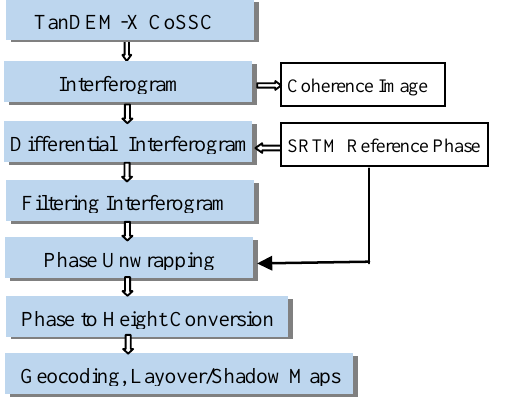
Figure 3. TanDEM-X inteferometric processing work flow. LiDAR and Digital Photogrammetric Stereo DEM are produced with 2 m resolution using the post processing software. For analysis, these DEMs have been resampled to the same projection (geographic lat/long, WGS84) and pixel size of TanDEM-X DEM.